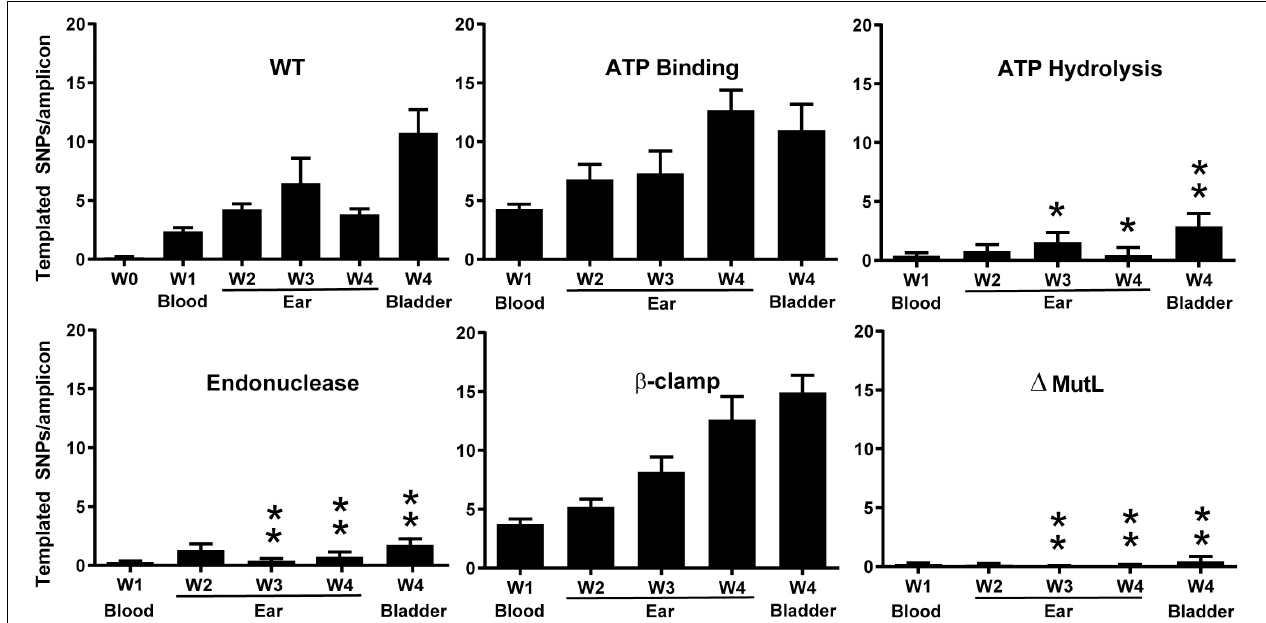
FIGURE 8 | The effect of mutations in MutL on recombinational switching at vlsE as measured by the number of templated SNPs per amplicon from NGS sequencing at weeks 1 in mouse blood and at weeks 1–4 in mouse ear and at week 4 in bladder. The wild-type week 0 sample was from spirochetes that were not used to infect mice. B. burgdorferi carrying the mutations described in Figure 6 was used to infect SCID mice as described in section “Experimental Procedures.” Mean ± SEM are shown. P values were determined for differences between WT and mutL mutants in the corresponding tissue type and time. A single asterisk indicates p < 0.05 and two asterisks indicated p < 0.01. P values were determined using two-sample t -test with unequal